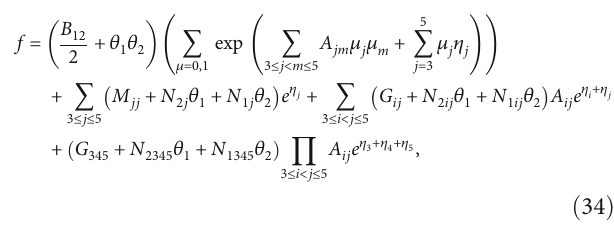
= 0 , β 0 = 0 , and β 0 = 10 . (c) 1 2 3